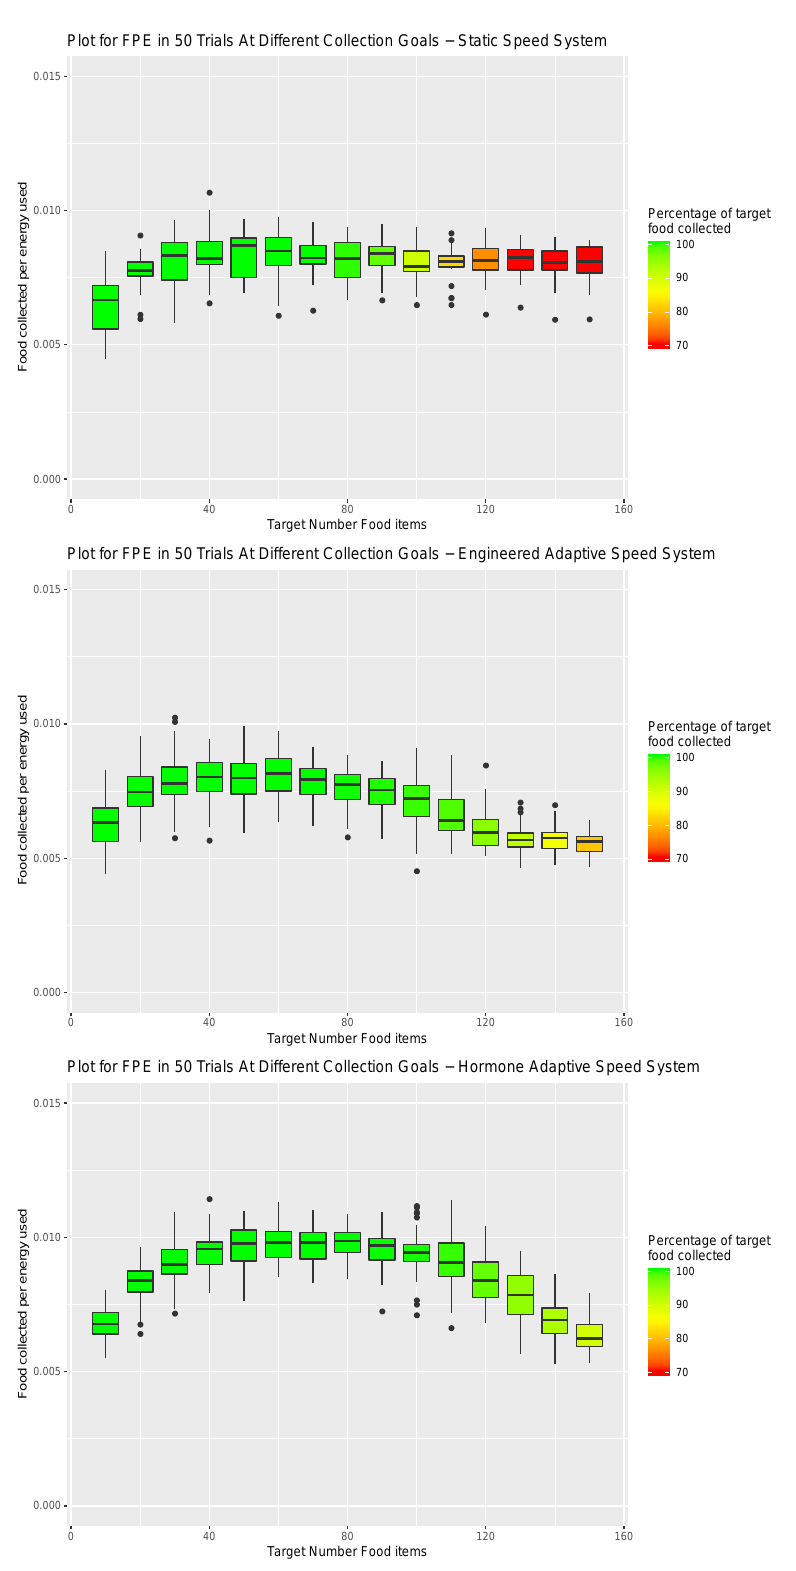
Figure 6. Target number for items collected ranged from 10 to 150 items of food. Percentage of the items requested versus those collected by the end of the simulation is indicated by colour (Green 100% and Red <